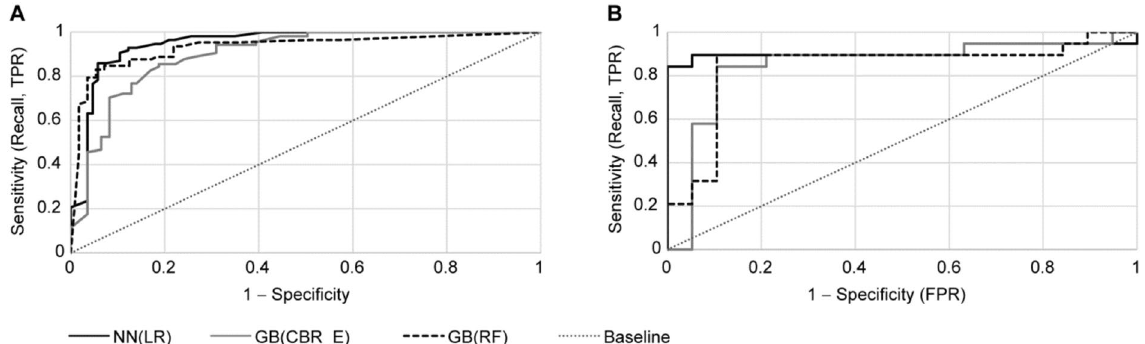
Figure 5. Receiver operating characteristic (ROC) curves of the three best performing classifiers for CBR data. (A) Averaged ROC curves of training and validation sets, (B) ROC curves for the test